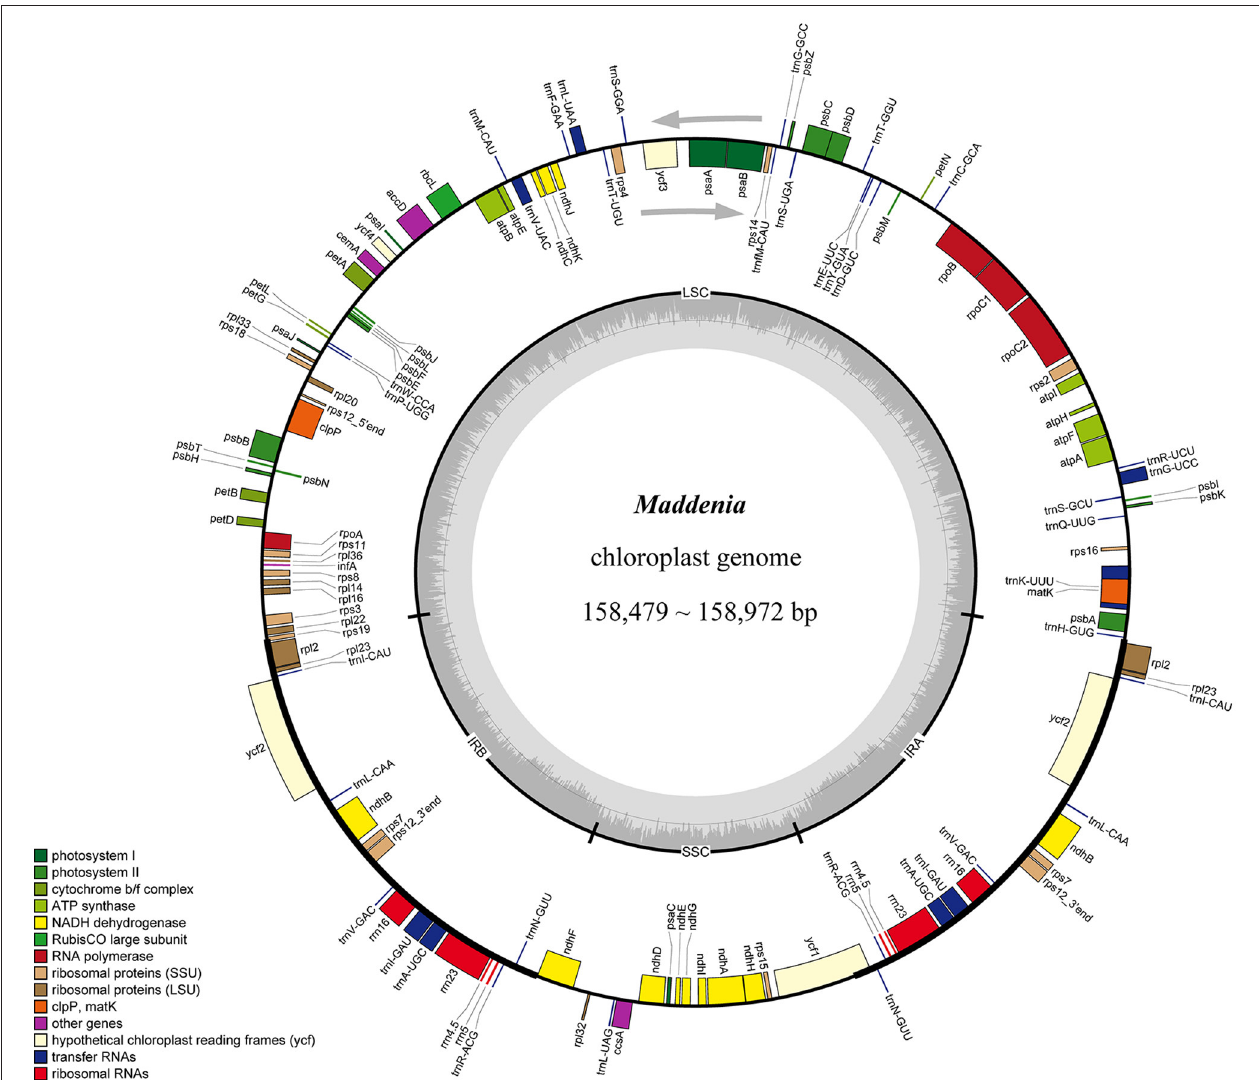
FIGURE 2 | Gene map of Maddenia chloroplast genome. The two gray arrows indicate the direction of gene transcription. The dashed area in the inner circle indicates the GC content of the plastome. LSC, large-single-copy; SSC, small-single-copy; IR, inverted repeat.